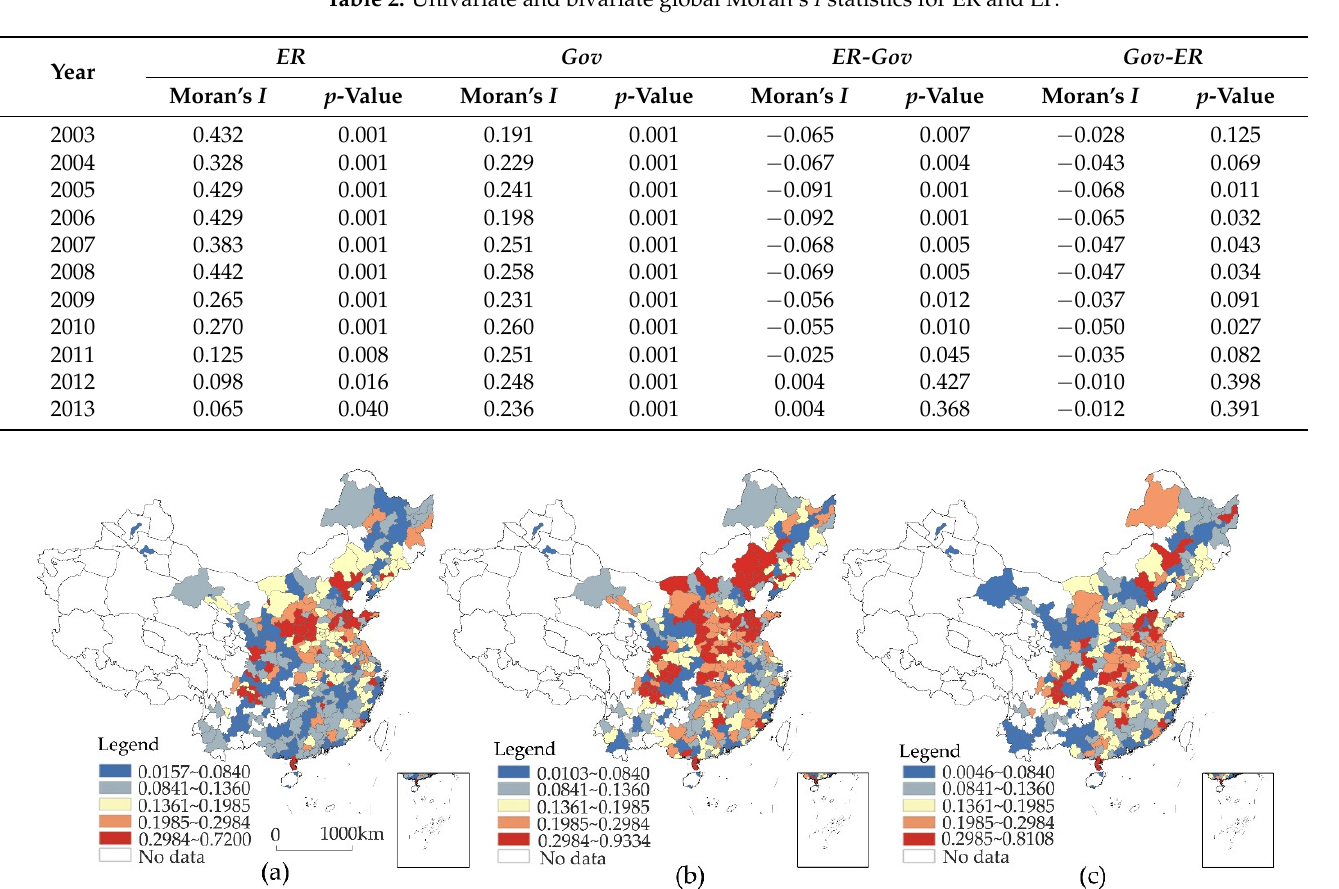
Figure 3. The spatial distribution and evolution of the LP index. ( a ) Local protection index in 2003; ( b ) local protection index in 2008; ( c ) local protection index in